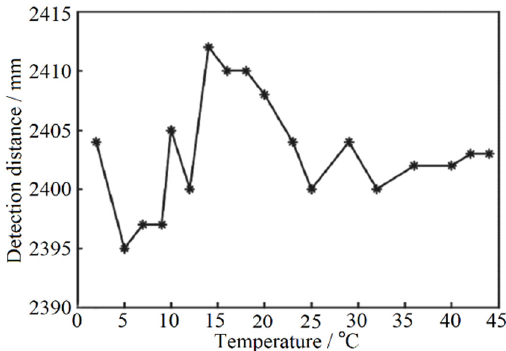
Figure 9. Ranging results after temperature correction. (* is the actual distance measurement result of the designed laser rangefinder.)